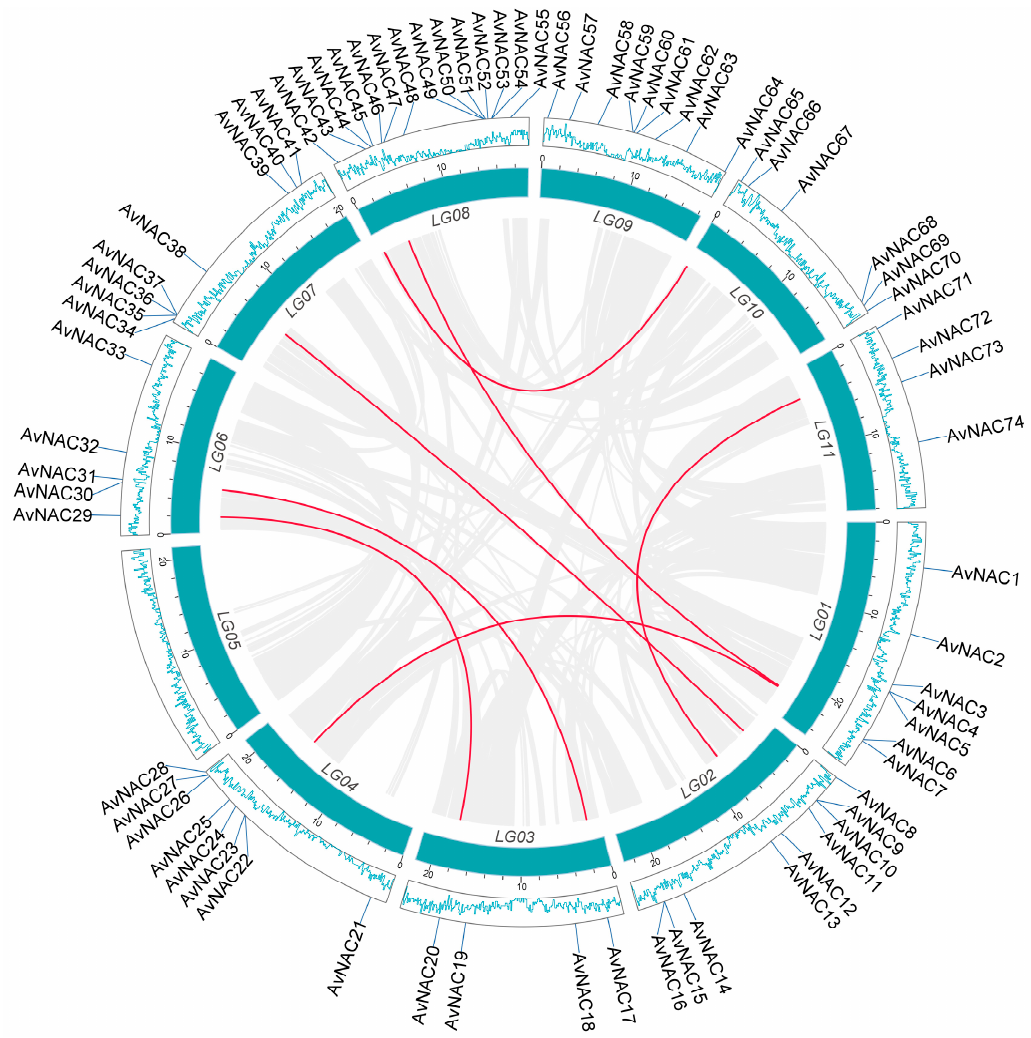
Figure 2. Collinearity analysis of the AvNAC genes. The blue box represents the chromosome, the lines inside the circle indicate collinear blocks within the A. venetum chromosome. The red lines indicate segment duplication events related to AvNAC genes. The blue lines inside the outer blocks indicate gene density.